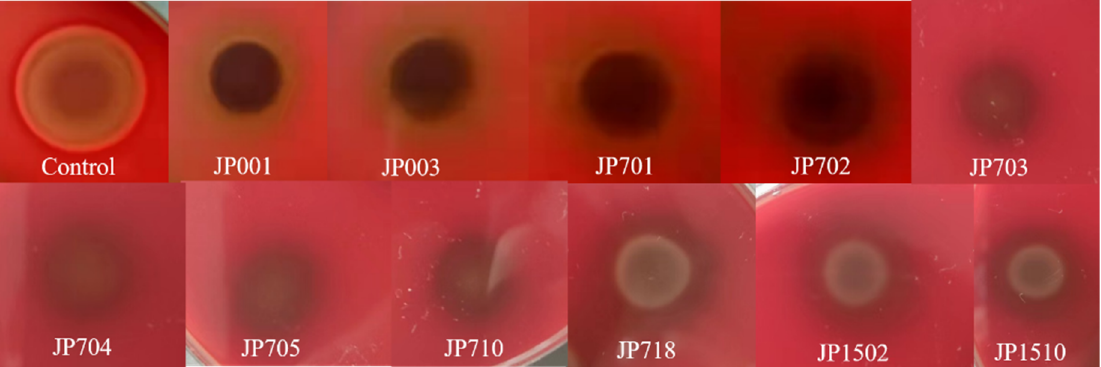
Figure 1. Hemolytic test of LAB strains. Hemolytic test results for S. aureus (Control) with transparent rings. None of the LAB strains produced circles of transparency. Table 6. Hemolytic activity and antibiotic susceptibility of LAB strains. Strain